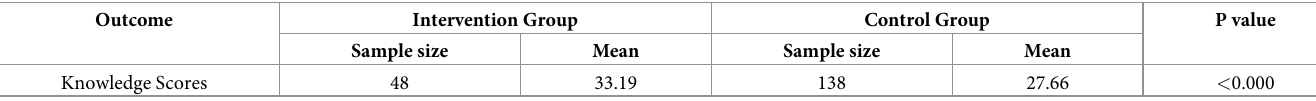
Table 2. Independent t-test analysis results to compare group means of knowledge scores.